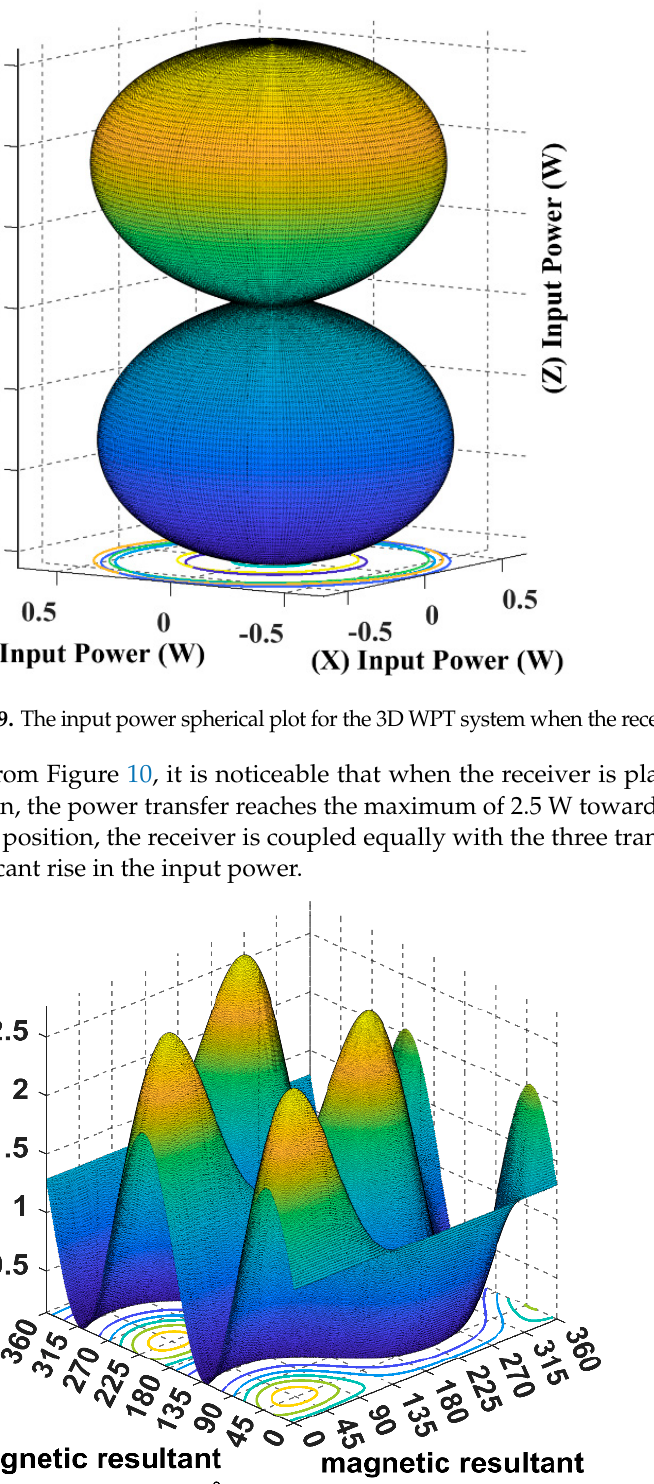
Figure 10. The input power plot for the 3D WPT system when the receiver is placed at α = φ = 45°.